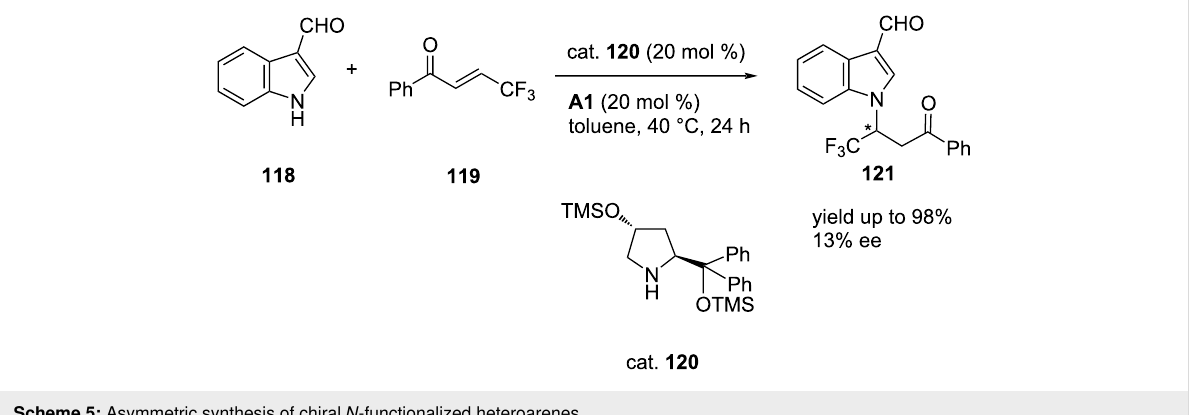
Scheme 5: Asymmetric synthesis of chiral N -functionalized heteroarenes.